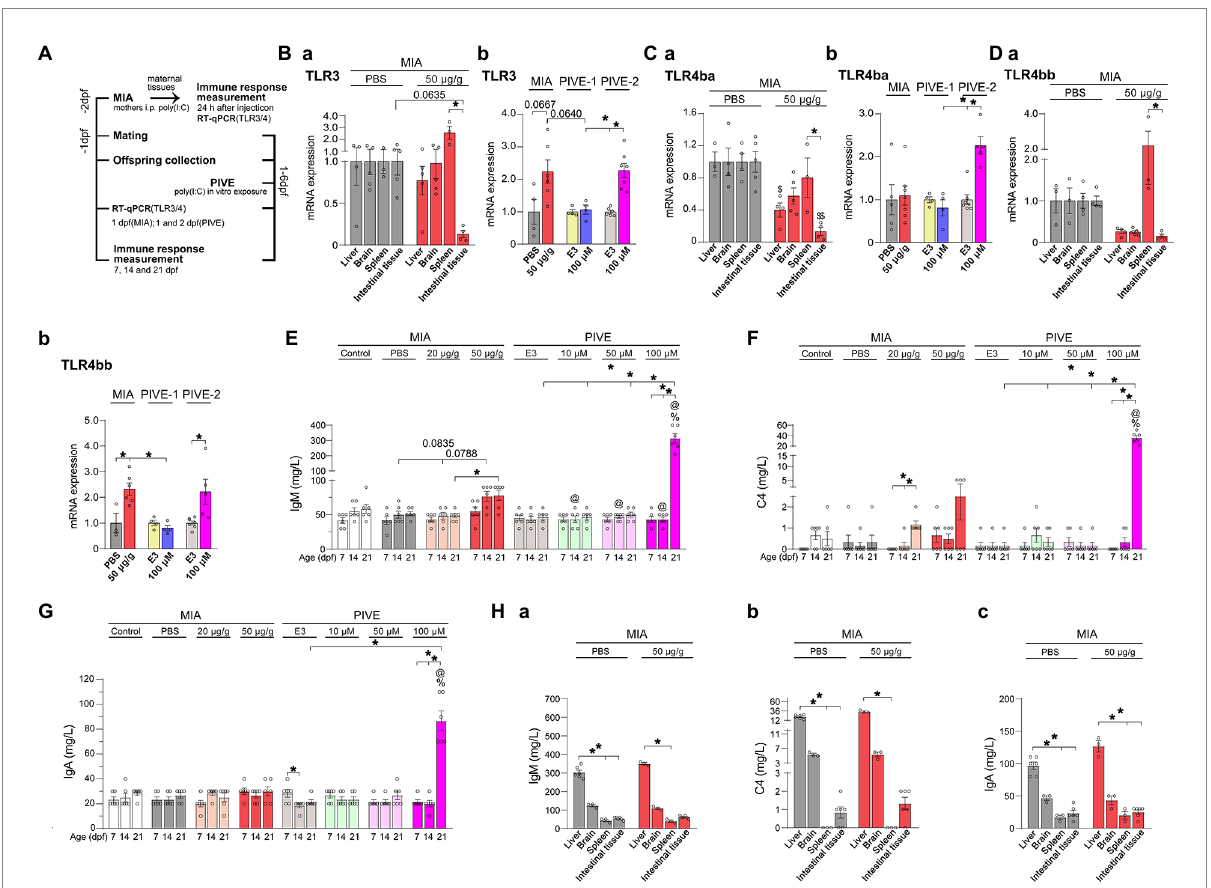
FIGURE 1 MIA offspring born to mothers injected with poly(I:C) showed an immune response. (A) For the maternal immune response induced by poly(I:C) (MIA-50 μ g/g), 24 h after injection, TLR3, TLR4ba, and TLR4bb genes were selected and detected by quantitative RT-PCR, and the immunoglobulin M (IgM), complement C4 (C4) and immunoglobulin A (IgA) levels were analyzed by the immunoturbdimetric assay method. For MIA offspring TLR3, TLR4ba, and TLR4bb gene levels and IgM, C4 and IgA levels were checked at 1 dpf; as well as for PIVE, TLR3, TLR4ba and TLR4bb gene levels and IgM, C4, and IgA levels were tested at 1 dpf (PIVE-1) or 2 dpf (PIVE-2) after a 24 h poly(I:C) treatment. (Ba) TLR3 mRNA expression was